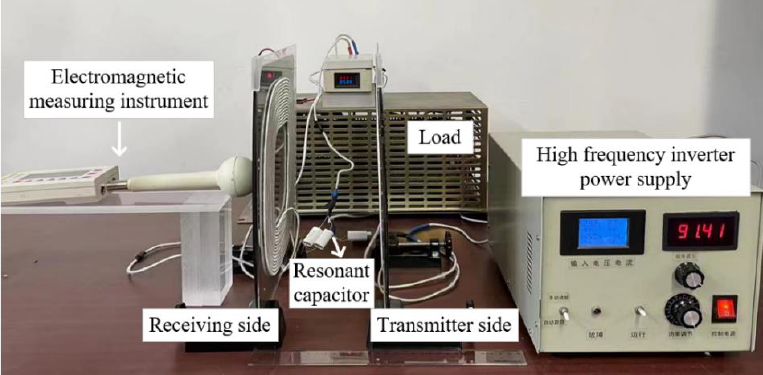
Figure 11. Experiment platform.